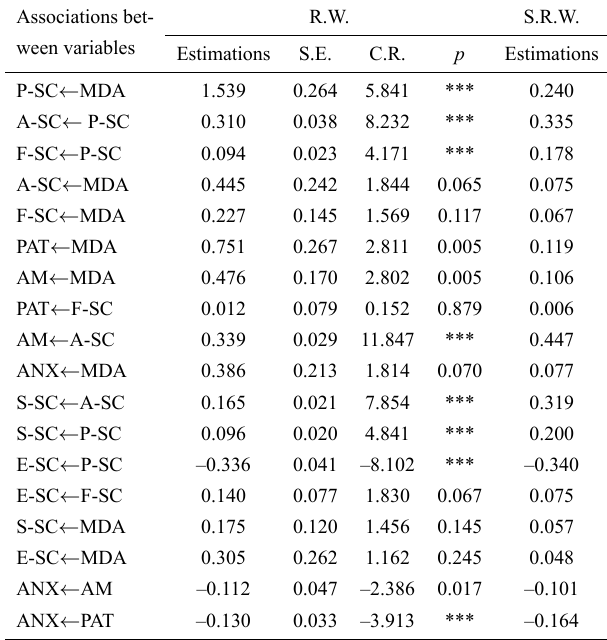
Table 6. The structural model for the theoretical model. Associations bet-